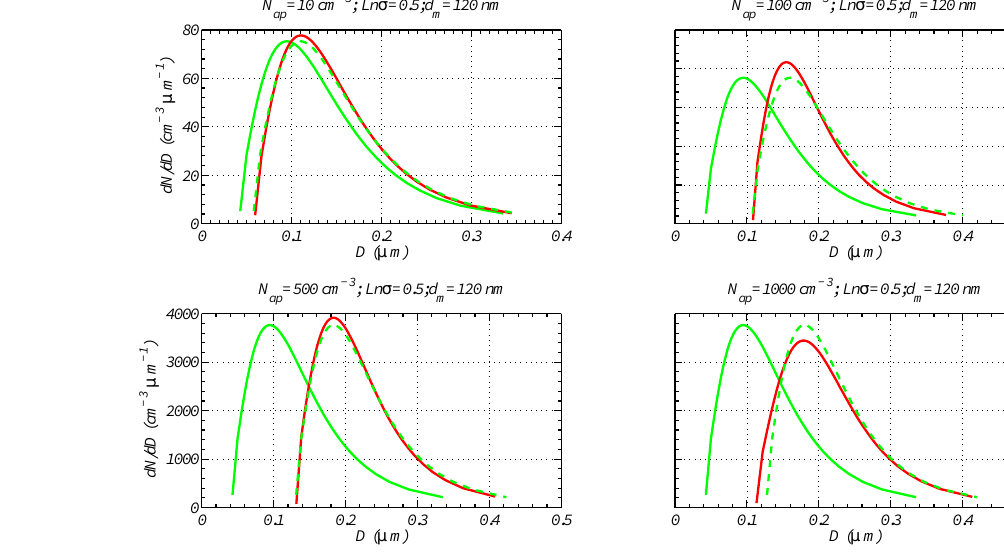
Fig. 5. Same as Figure 4 but plotted on a linear scale for the diameter. Fig. 5. Same as Fig. 4 but plotted on a linear scale for the